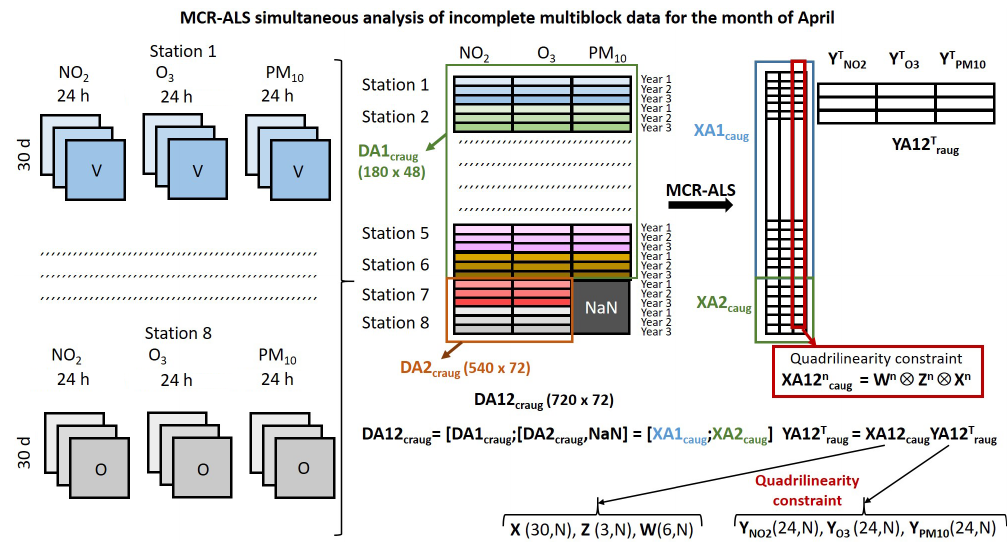
Figure 3. MCR-ALS with the quadrilinearity constraint for the simultaneous analysis of the three contaminants in the incomplete multiblock data set for the month of April. See Eq. (9) and their explanation in the